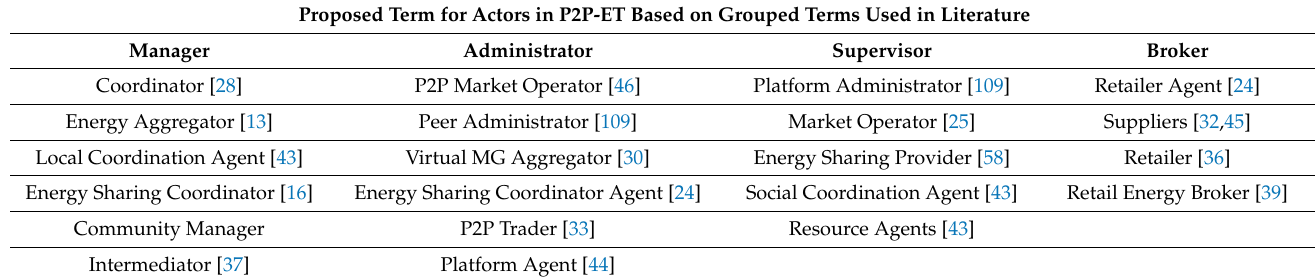
Table 7. Terms used in literature for referring to proposed actors in P2P-ET markets. Proposed Term for Actors in P2P-ET Based on Grouped Terms Used in